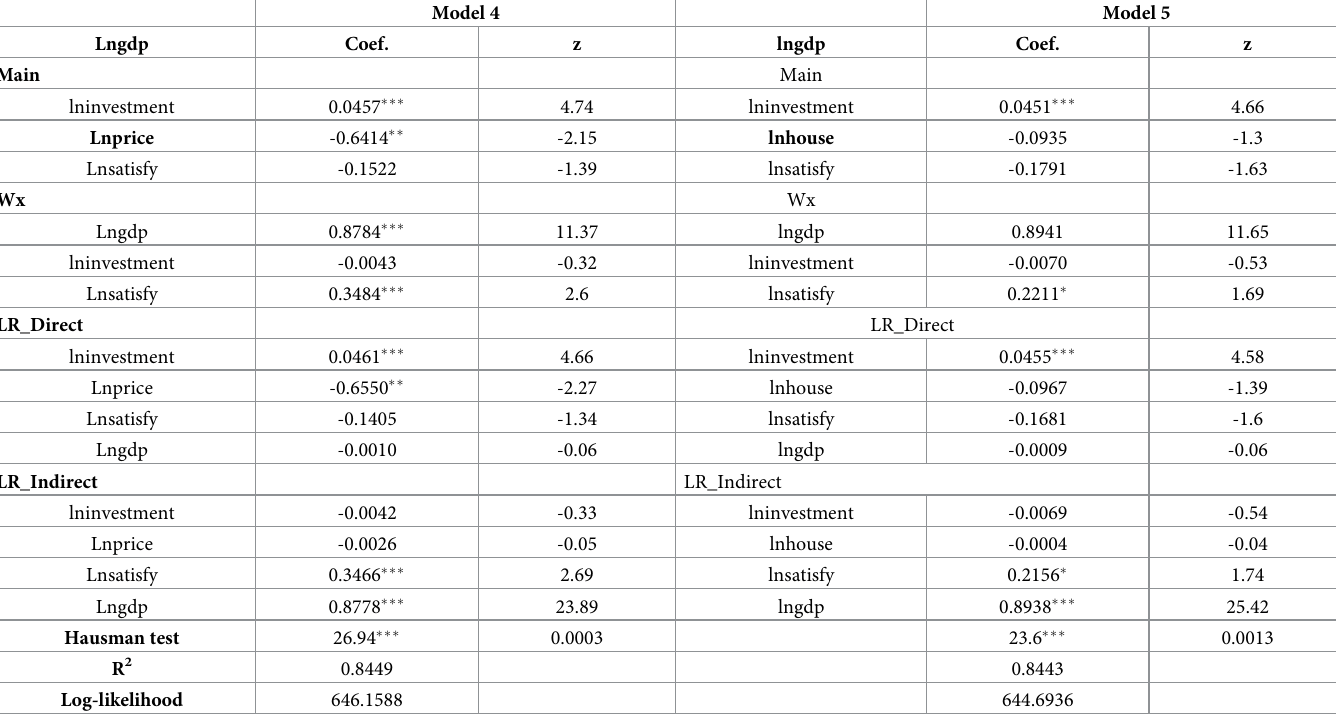
Table 7. SDM regression results for urban tourist satisfaction and GDP (continued).